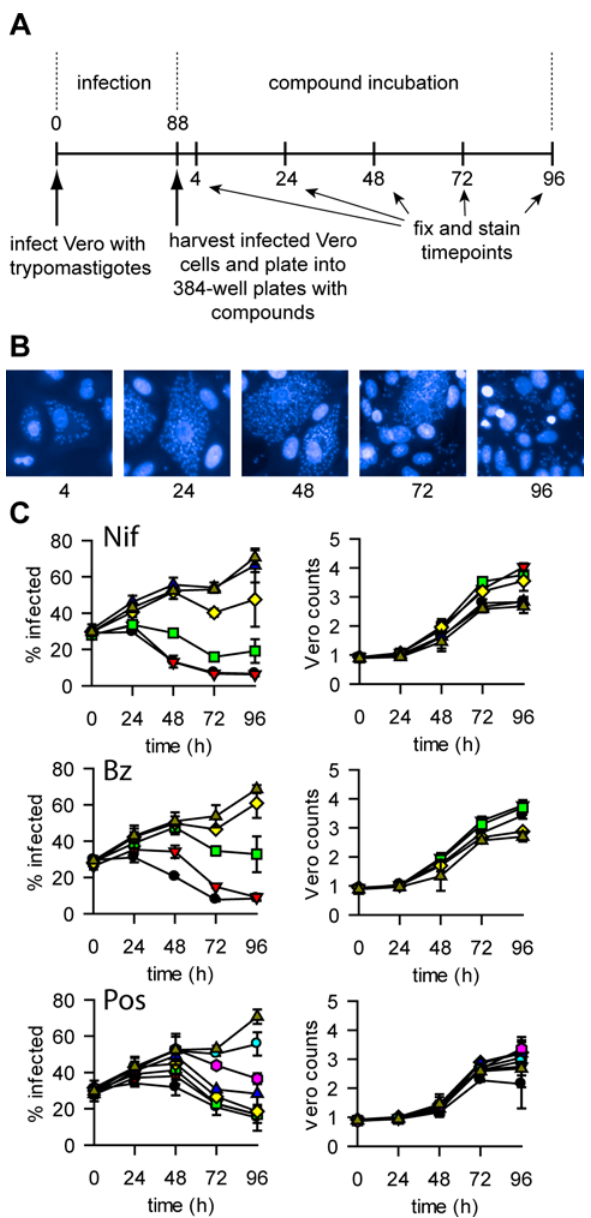
Fig 4. T . cruzi rate-of-kill assay. Panel A. Outline of the rate-of-kill assay. Numbers are time in hours. Times above the timeline are from addition of the trypomastigotes, times below the line are starting from addition of the infected cells to the plates containing compounds. Panel B. Representative images from untreated wells in the static-cidal assay at the different time-points. Panel C. Rate-of-kill profiles. Left panel shows percent infected cells against time, right panel shows Vero counts against time (n = 3, error bars = standard deviation) for Nifurtimox (top), Benznidazole (middle) and Posaconazole (bottom). Concentrations are as follows ( μ M) (all compounds were tested at the same concentrations except for Posaconazole, its concentrations are shown between brackets): black circle 50 (1), red triangle 17 (0.3), green square 5.6 (0.1), yellow diamond 1.9 (0.04), blue triangle 0.6 (0.01), pink hexagon 0.2 (0.004), cyan circle 0.07 (0.001), triangle dark yellow